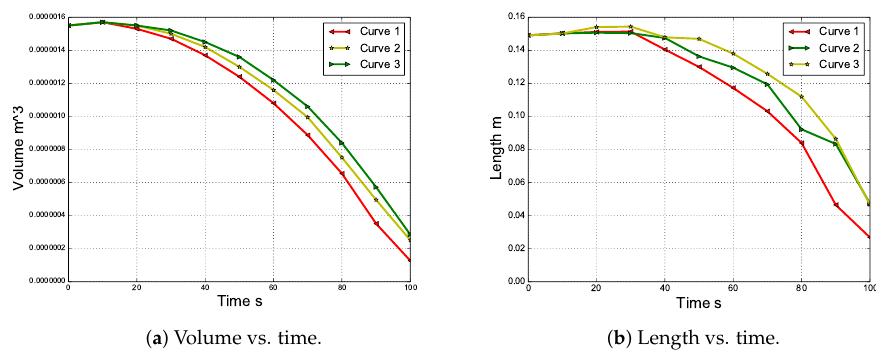
Figure 11. Evolution of the length and volume simulated with PFEM.